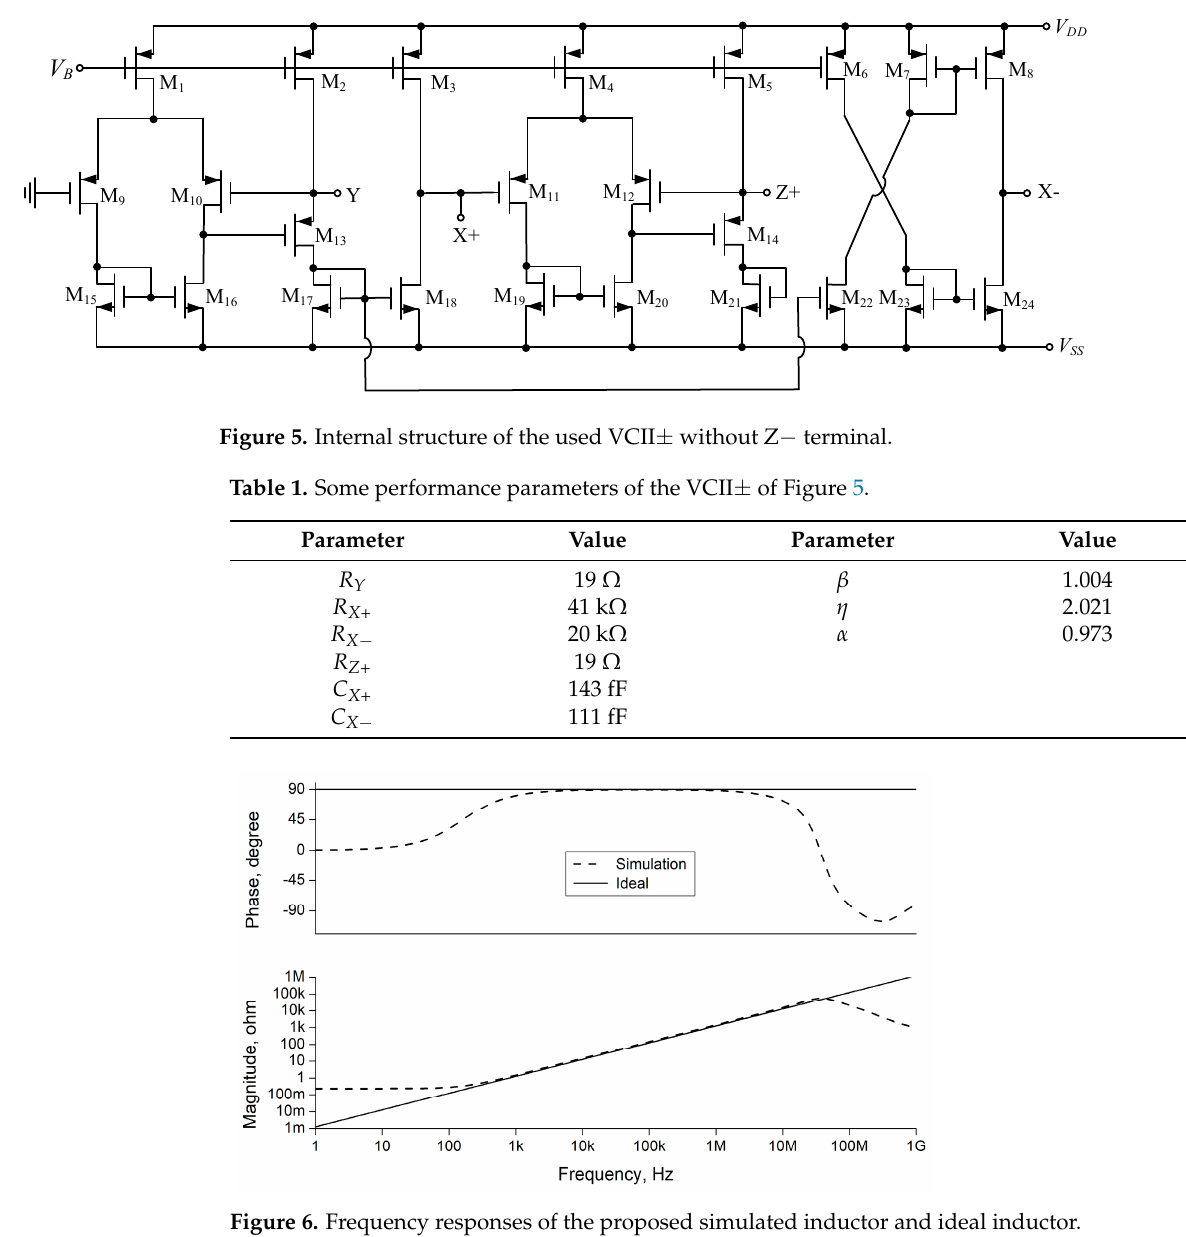
Figure 6. Frequency responses of the proposed simulated inductor and ideal inductor.